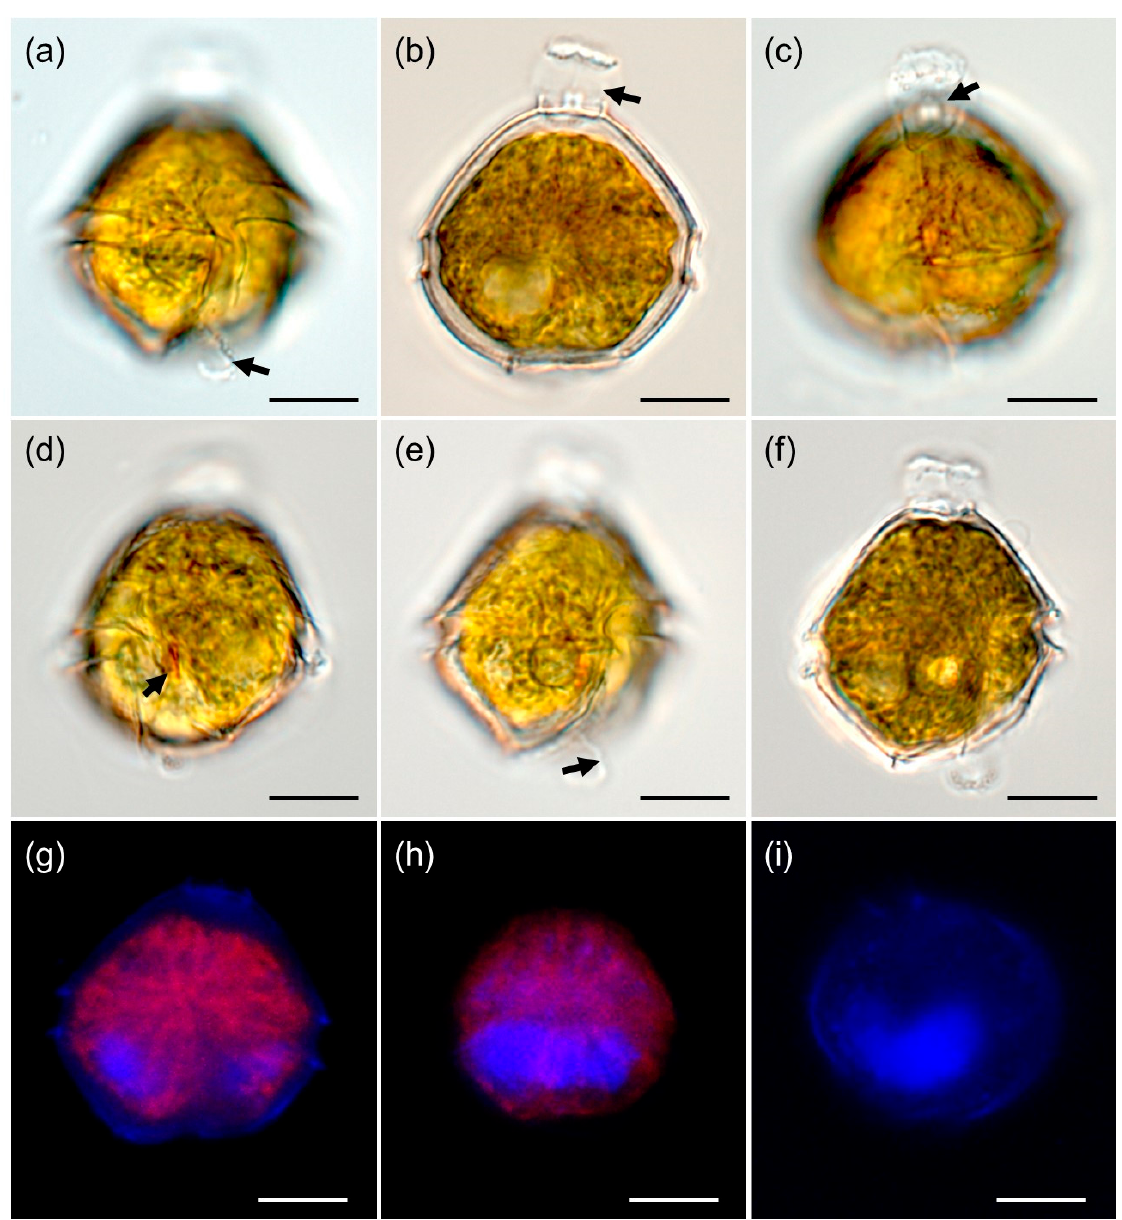
Figure 1. Light micrographs of Bysmatrum subsalsum (Strain: LIMS-2685). ( a ) Surface focus of ventral view showing the longitudinal flagella (arrow), sulcus and cingulum. ( b ) Deeper focus of ventral view showing the outline of the cell and apical stalk (arrow). ( c ) Surface focus of ventral-apical view showing the apical stalk (arrow). ( d ) Deeper focus of ventral-lateral view showing a red eyespot (arrow). ( e ) Surface focus of ventral-right lateral view showing the longitudinal flagella (arrow). ( f ) Deeper focus of dorsal view. ( g ) Epifluorescence image of ventral view of DAPI-stained cell showing the position of the nucleus. ( h ) Epifluorescence image of dorsal view of DAPI-stained cell showing the position of the nucleus. ( i ) Epifluorescence image of antapical view of DAPI-stained cell showing the shape of the nucleus. Scale bars = 5 µm.